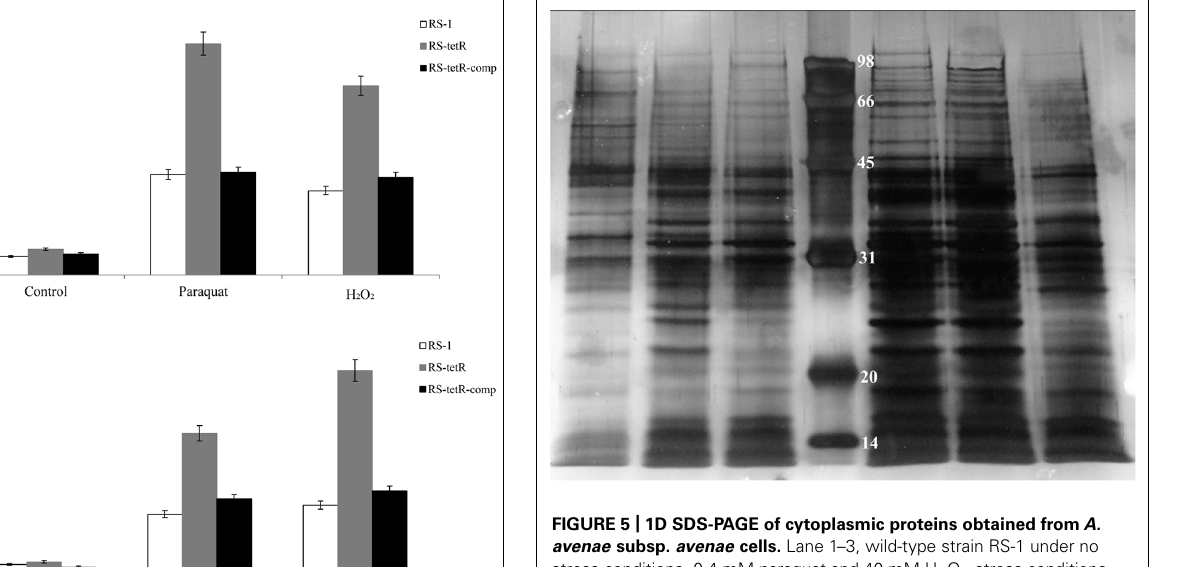
IDENTIFICATION OF PROTEINS REGULATED BY TetR